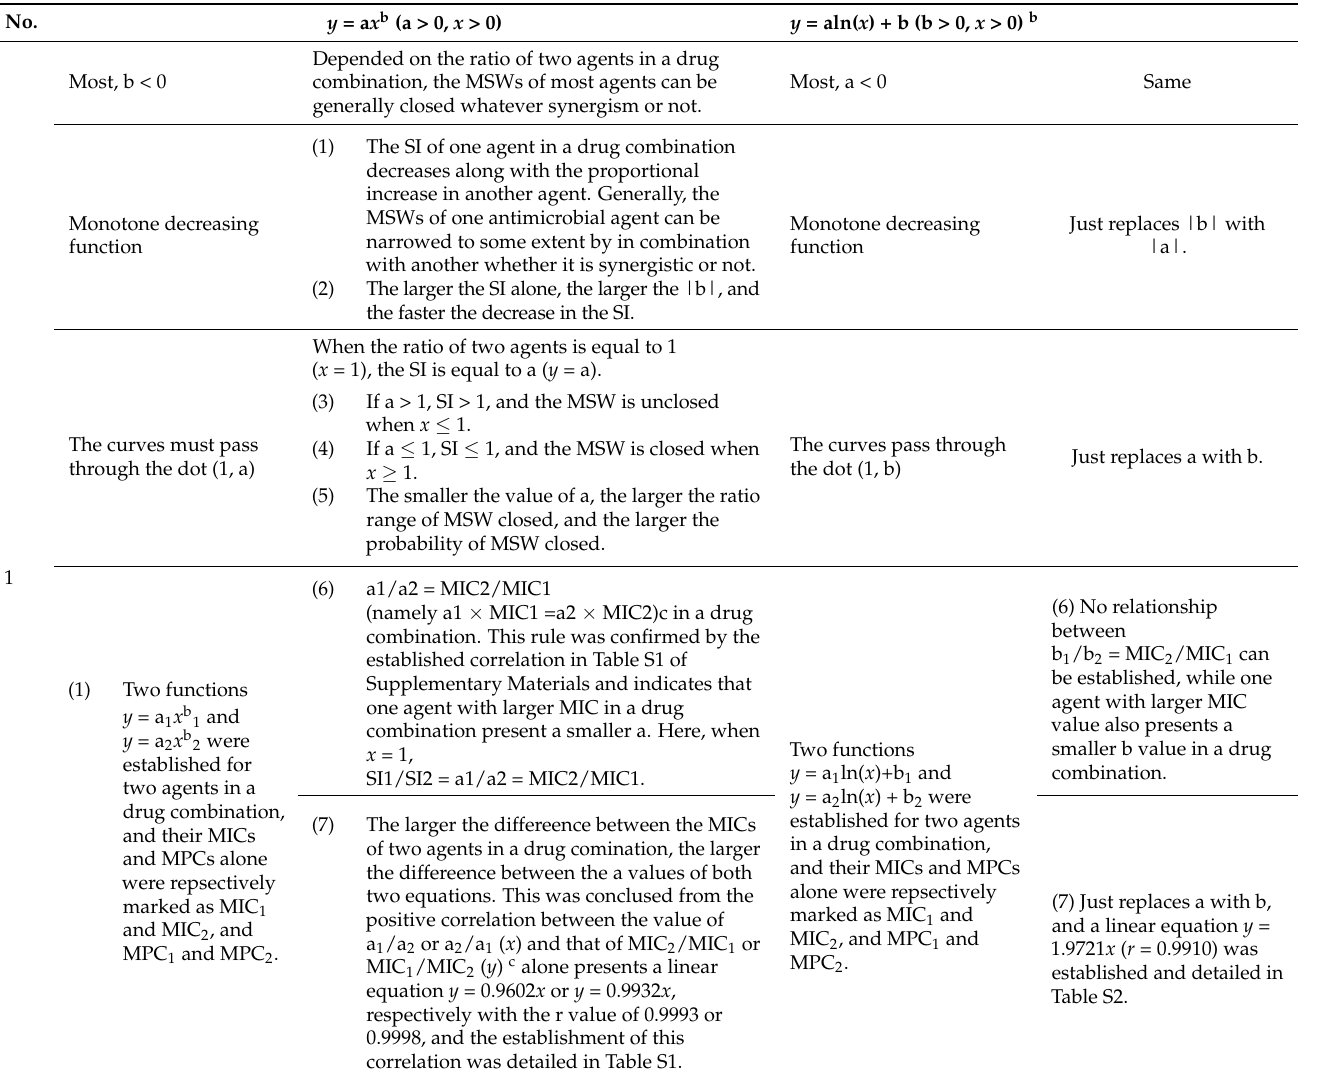
Table 2. Communications between the mathematical characteristics and the related indexes of bacterial resistance, of the functions for two agents in a drug combination a